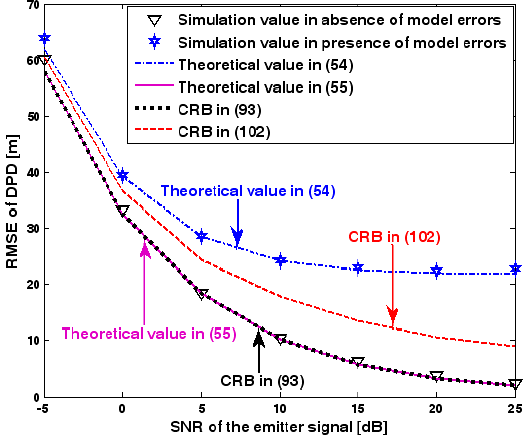
Figure 8. RMSE of DPD as a function of SNR of the emitter signal.